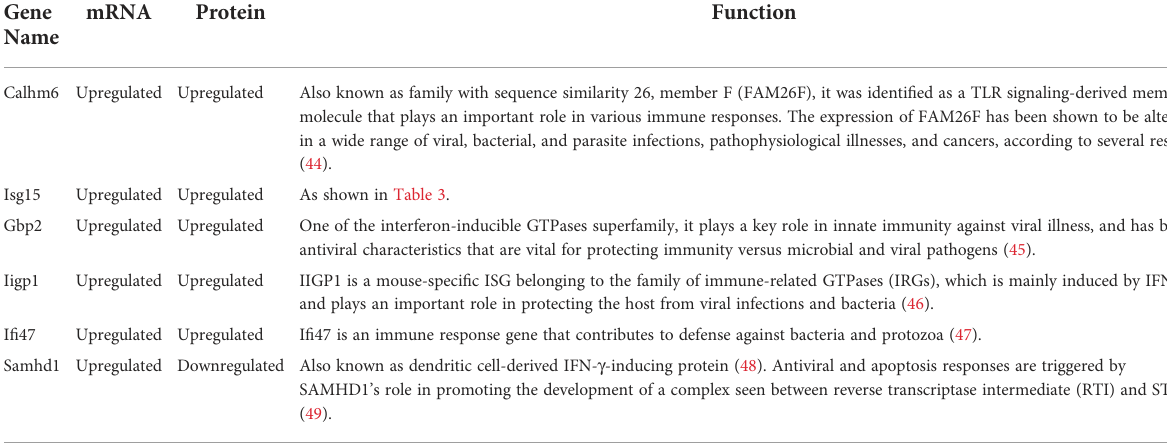
TABLE 7 Gene/protein information showing correlation on transcriptome and